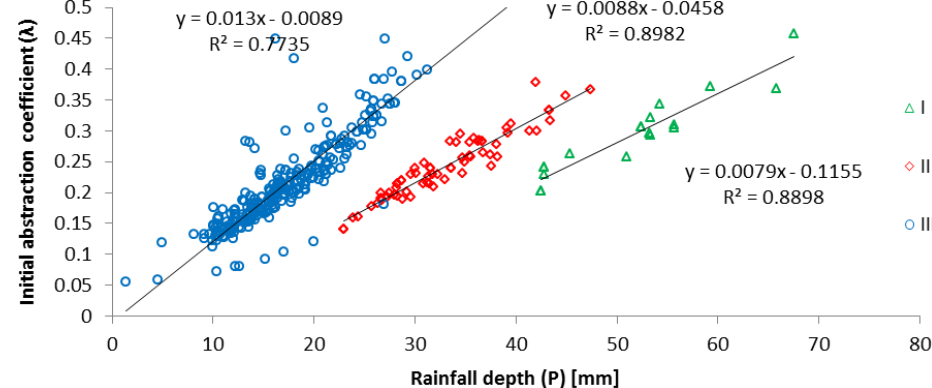
Figure 2. Relationship between initial abstraction coefficient ( λ ) and event rainfall ( P ) for the Upper Hron River basin events.